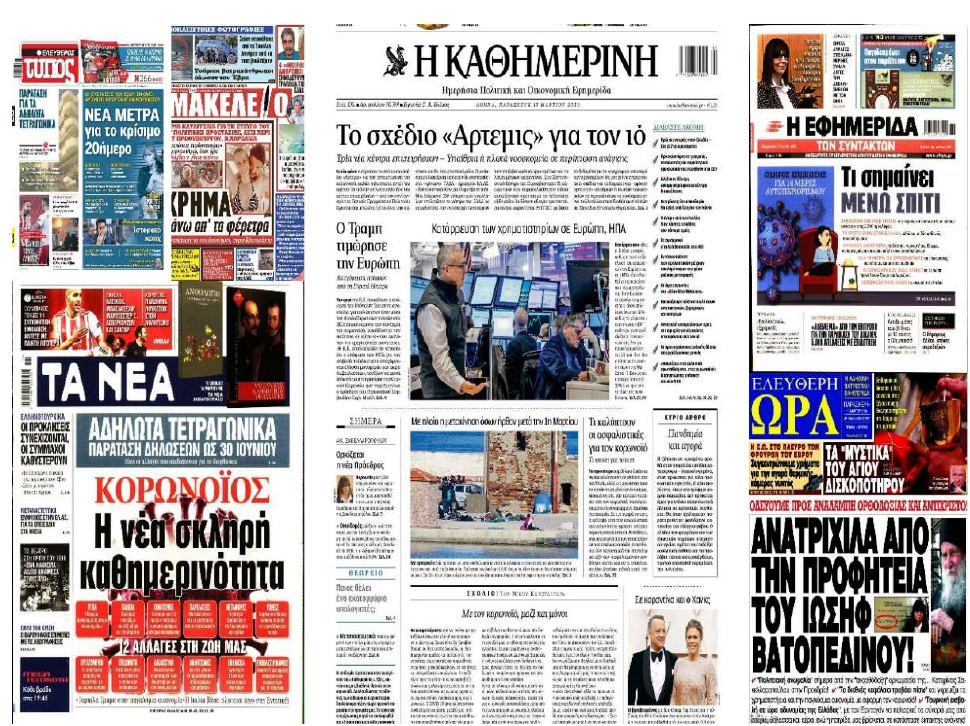
Figure 1. The newspapers’ front pages on 13 March 2020.